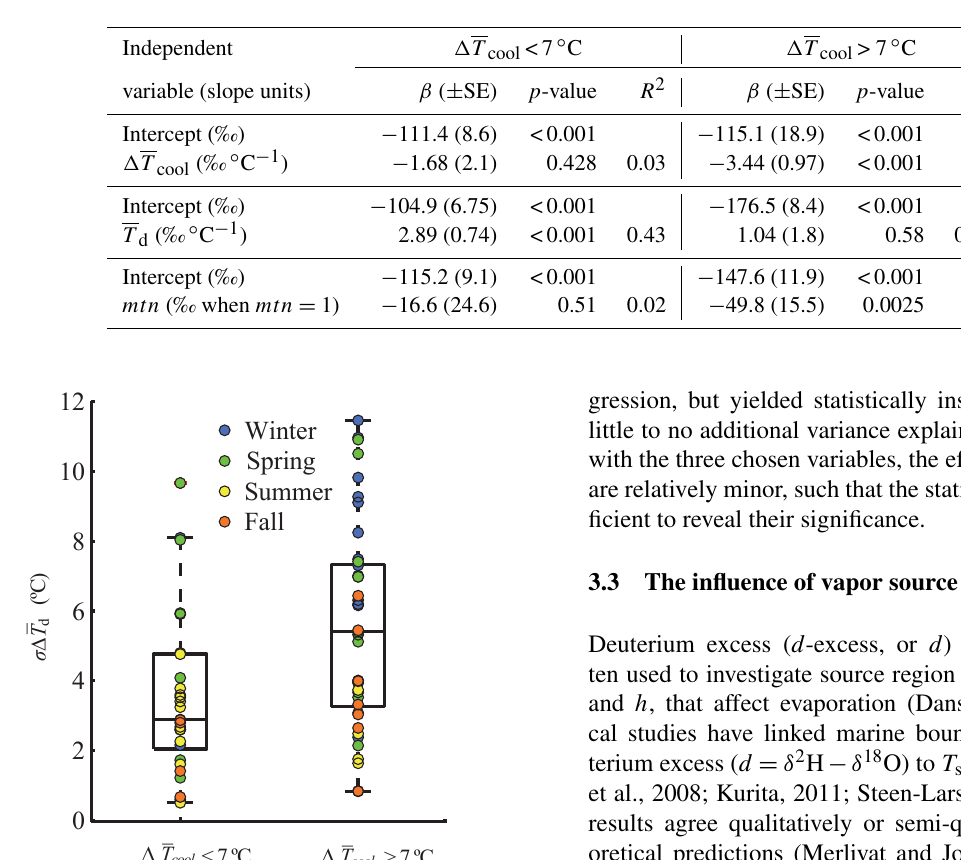
Table 2. Three simple linear regressions against δ 2 H, where β is the regression coefficient and SE is the standard error. Source conditions parameterized by T d explain most variation in δ 2 H for small (cid:49)T cool , while topographic highs below the trajectory ( mtn ) explain substantial variation for large (cid:49)T cool . (cid:49)T cool explains variability significantly only for the long transport subgroup ( (cid:49)T cool >7 ◦ C).